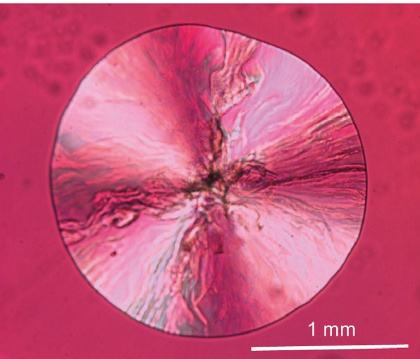
Figure 2: Photomicrographs of APAP crystal taken at 40 ° C. The scale bar represents 1mm.